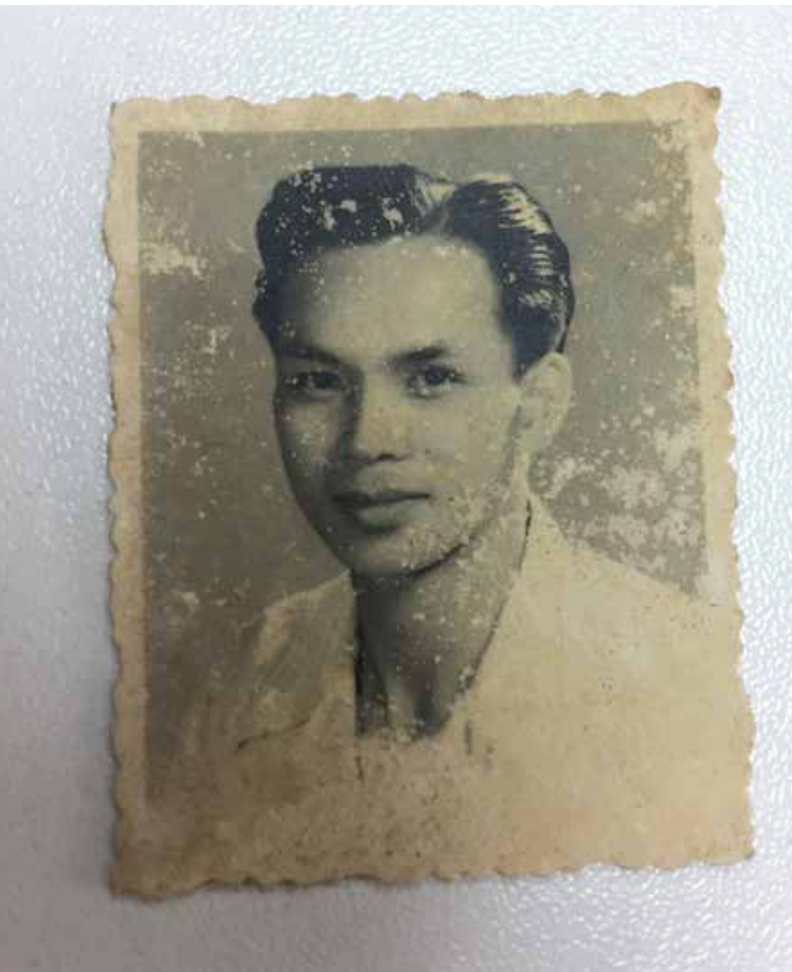
Figure 1: Ha Bik-Chuen. Source: courtesy of the Ha Family and Asia Art